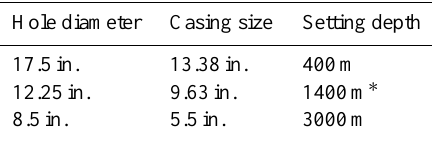
Table 1. Well scheme. Hole